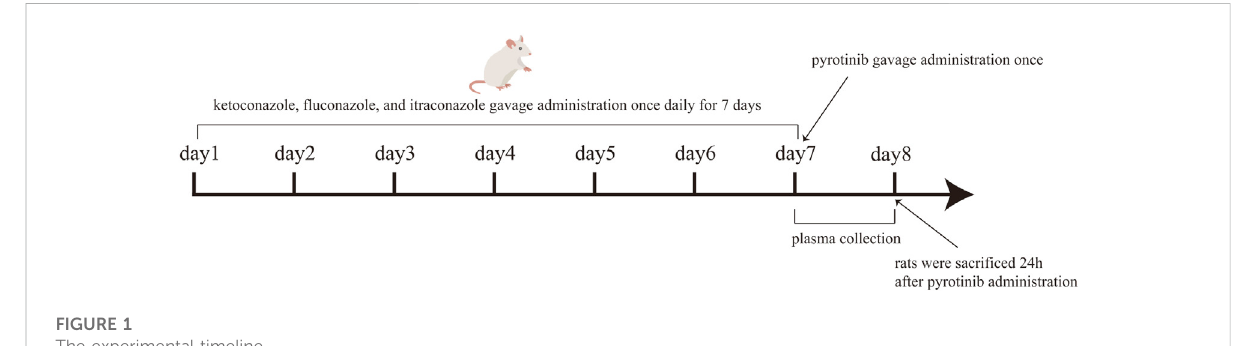
FIGURE 1 The experimental timeline.